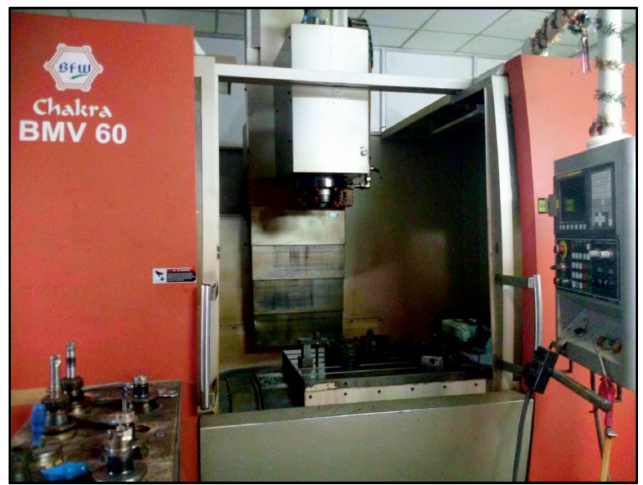
Figure 3. CNC milling machine.